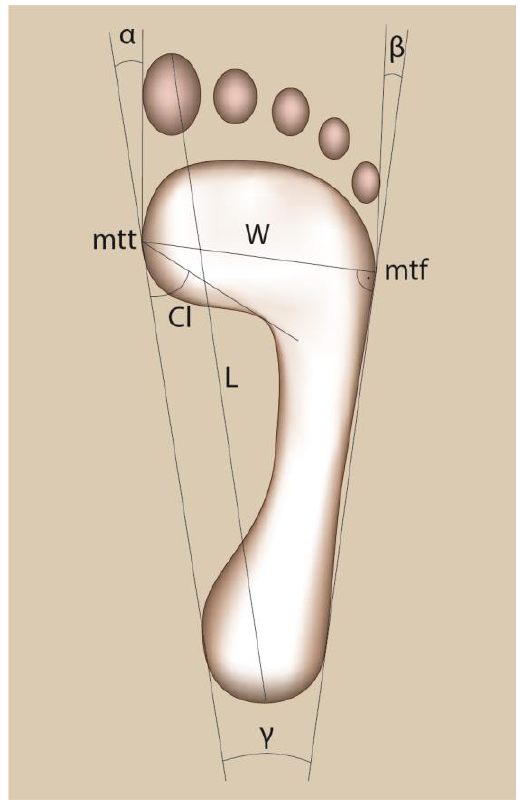
Figure 1. The manner of marking the feet structure